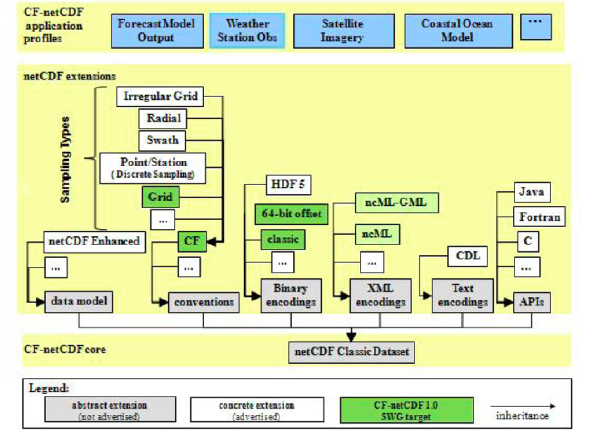
Figure 3. CF-NetCDF Specification